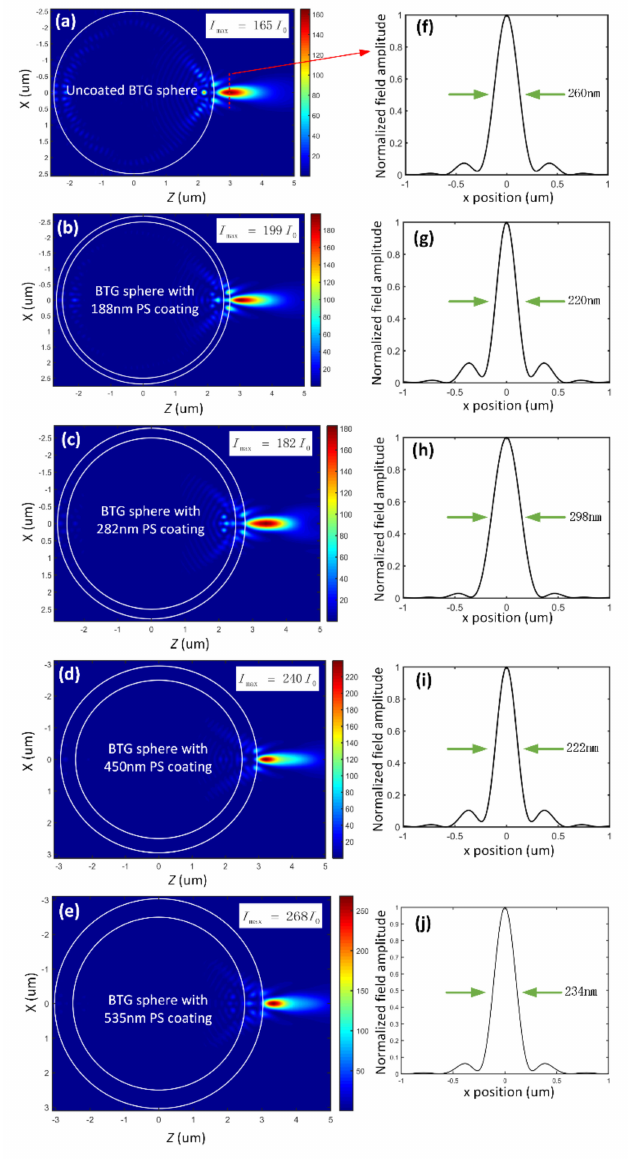
Figure5. Intensitydistributionsandfullwidthsathalfmaximum(FWHMs)arounda2.5 µ m-core-radius BTG sphere with di ff erent PS coating thickness: ( a ) uncoated BTG sphere, ( b ) BTG sphere with 188-nm PS coating thickness, ( c ) BTG sphere with 282-nm PS coating thickness, ( d ) BTG sphere with 450-nm PS coating thickness and ( e ) BTG sphere with 535-nm PS coating thickness. ( f – j ) FWHMs of